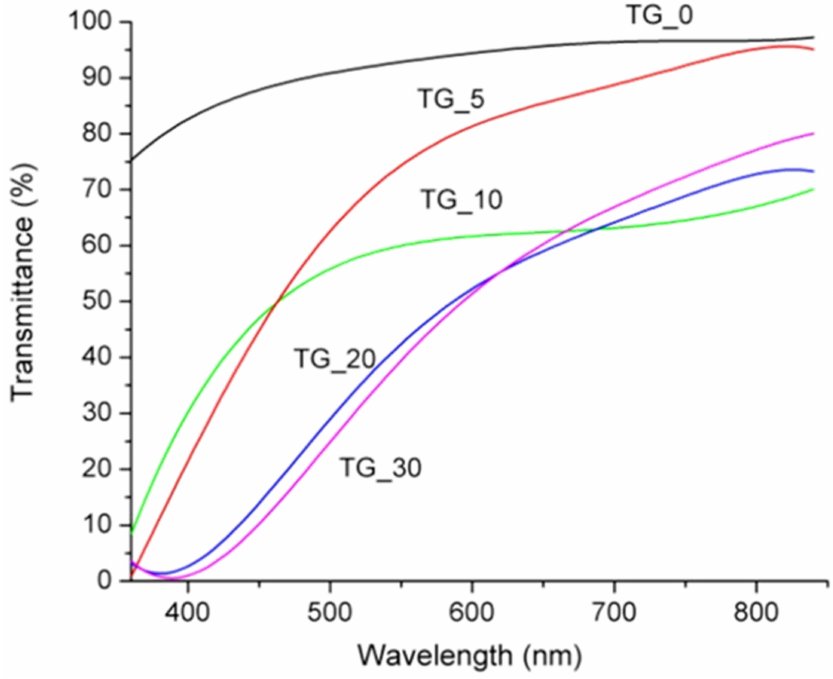
Figure 4. Spectral transmittance of the TG_X films (X − 0, 5, 10, 20, and 30% of